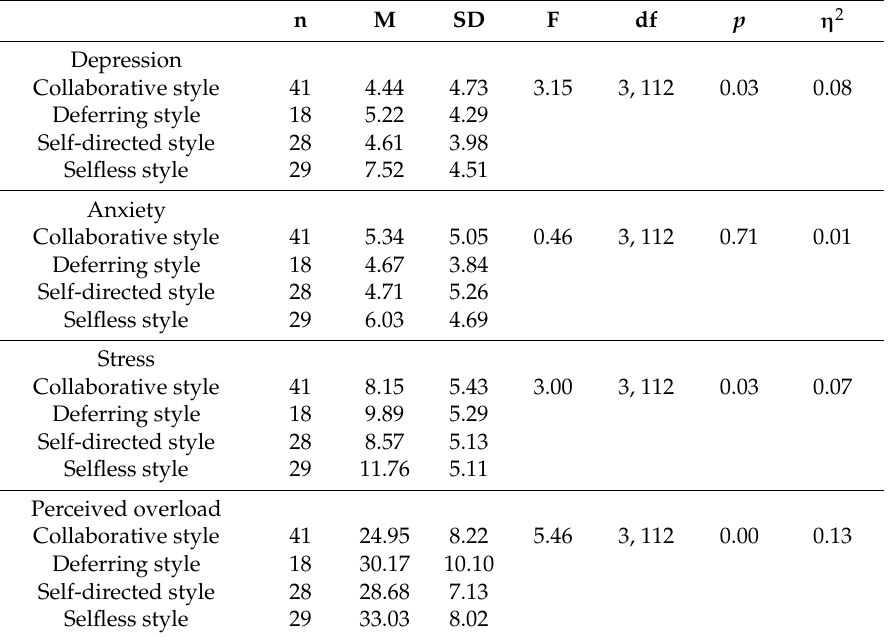
Table 4. Results for the Multiple Analysis of Variance